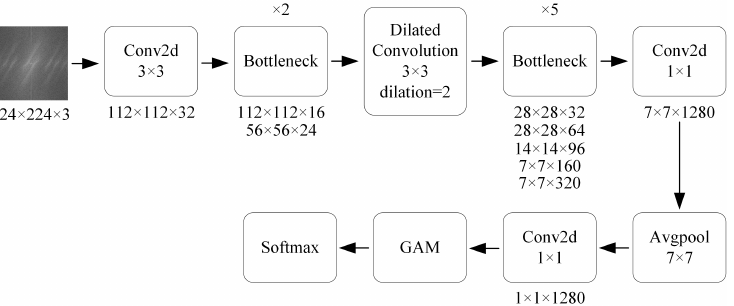
Figure 4. MobileNetV2g model